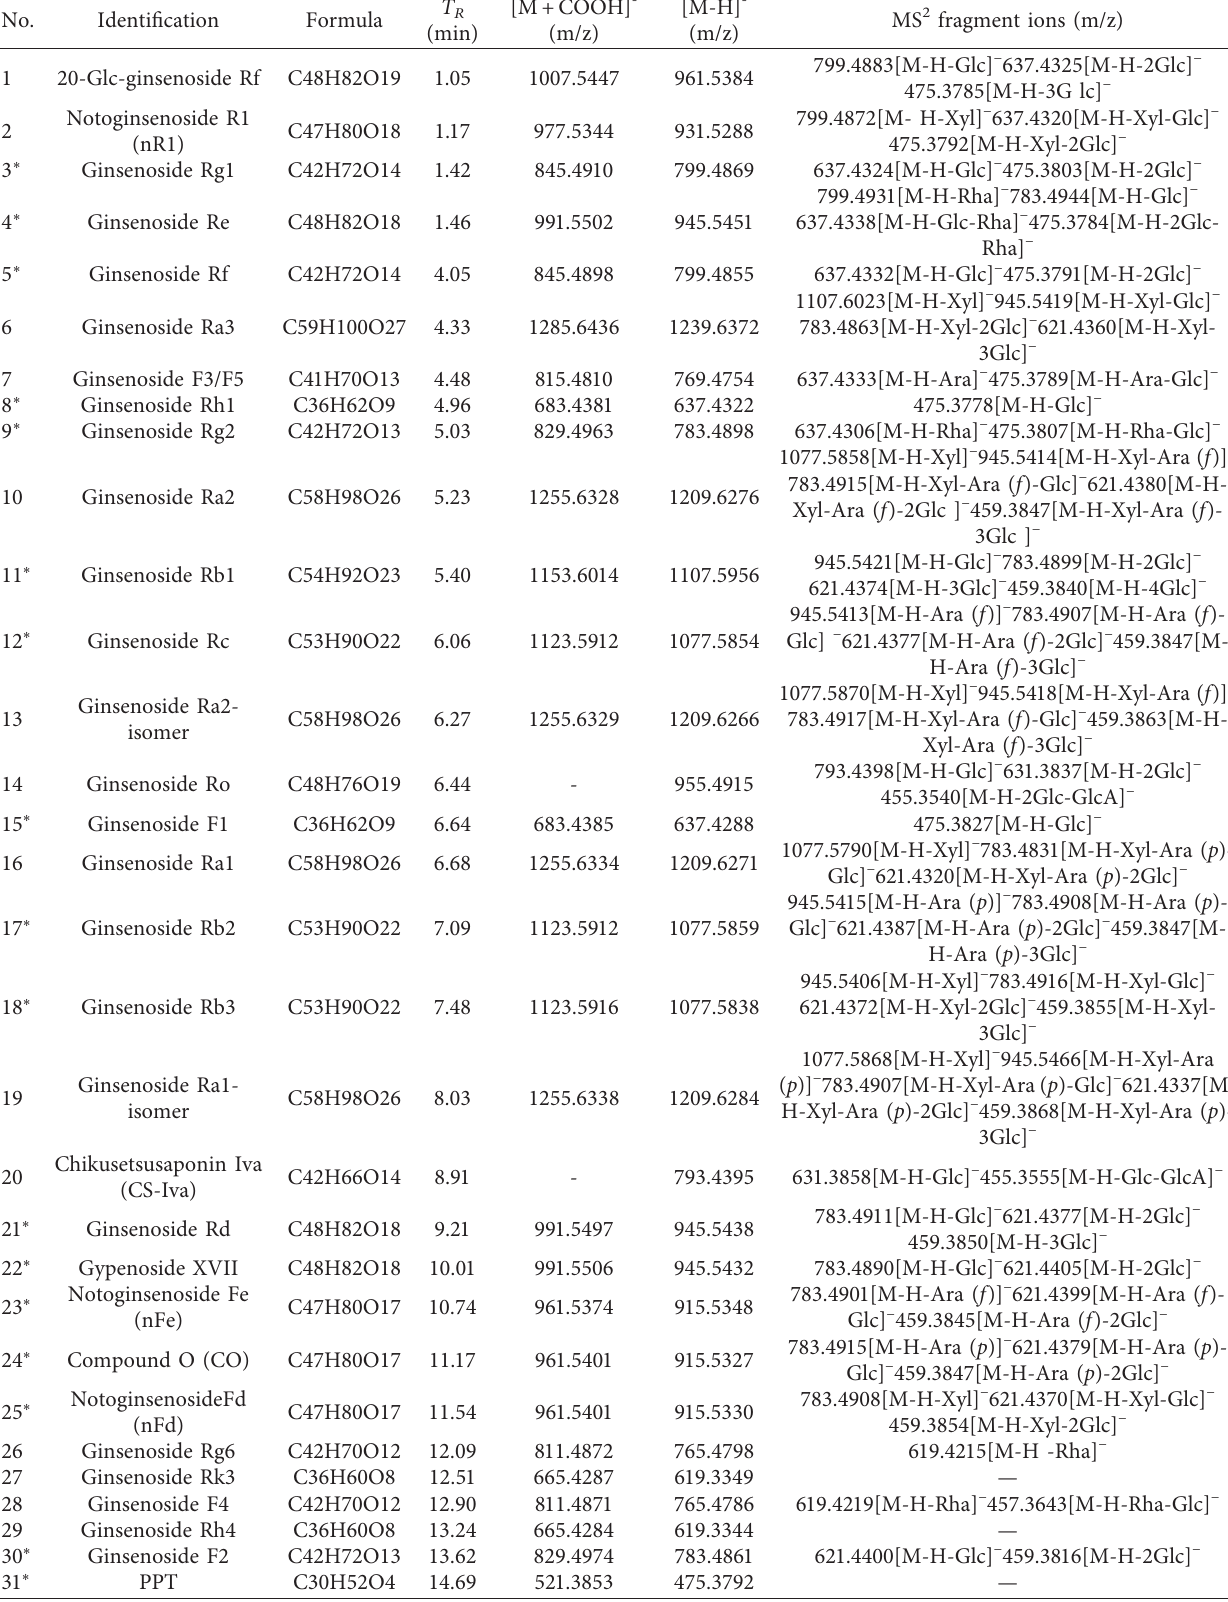
Table 3: Characterization of compounds in Panax ginseng roots using